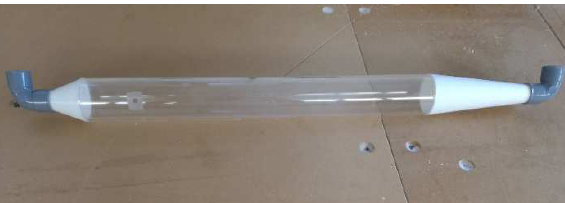
Fig. 2. Pipe with the sharp edged orifice, the divergent reach and the convergent reach; flow from right to